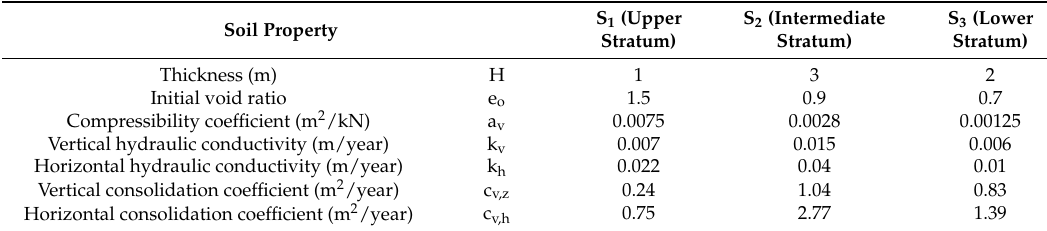
Table 2. Thickness and properties of the three strata.